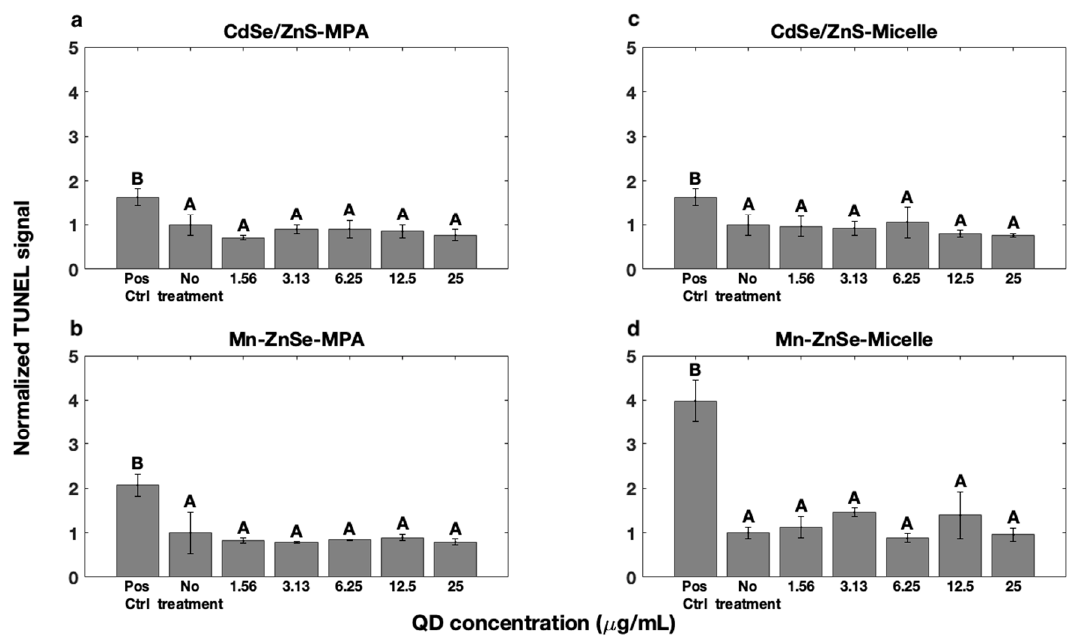
Figure 4. Assessment of DNA fragmentation for ( a , c ) CdSe/ZnS and ( b , d ) Mn-doped ZnSe QDs ( a , b ) coated with MPA surface ligands or ( c , d ) encapsulated in PS-PEO polymer micelles. DNase exposure provided a positive control. All results are normalised to no-treatment, negative controls. Bars connected by different letters display statistically significant differences. Thus, bars connected by A are statistically indistinguishable from negative controls receiving no treatment, and statistically different from positive controls samples exposed to DNase (i.e., samples connected with B).